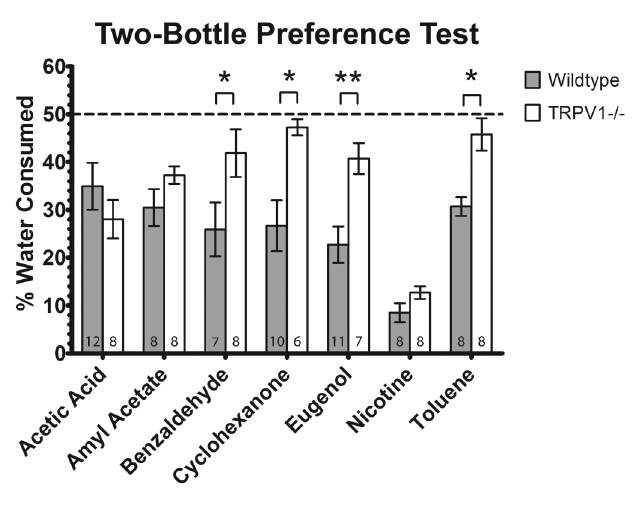
Figure 3. TRPV1 knockout mice show significant deficiencies in the ability to detect benzaldehyde, cyclohexanone, eugenol and toluene. Results are from the two-bottle preference test. Mean ± SEM percentage of water consumed from the irritant-treated tube by wildtype and TRPV1-/- mice. Two-way ANOVA revealed a significant difference among irritants ( P <0.001), genotype ( P <0.001) and interaction between the two factors ( P <0.01). Knockout mice drank significantly more than wildtype mice from bottles treated with benzaldehyde ( P <0.05), cyclohexanone ( P <0.05), eugenol ( P <0.01) and toluene ( P <0.05). The number of mice in each experimental group is indicated at the foot of each bar. *P<0.05, **P<0.01, ***